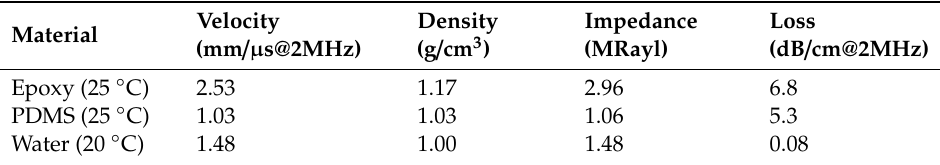
Table A3. Acoustic properties of materials, distilled water, and